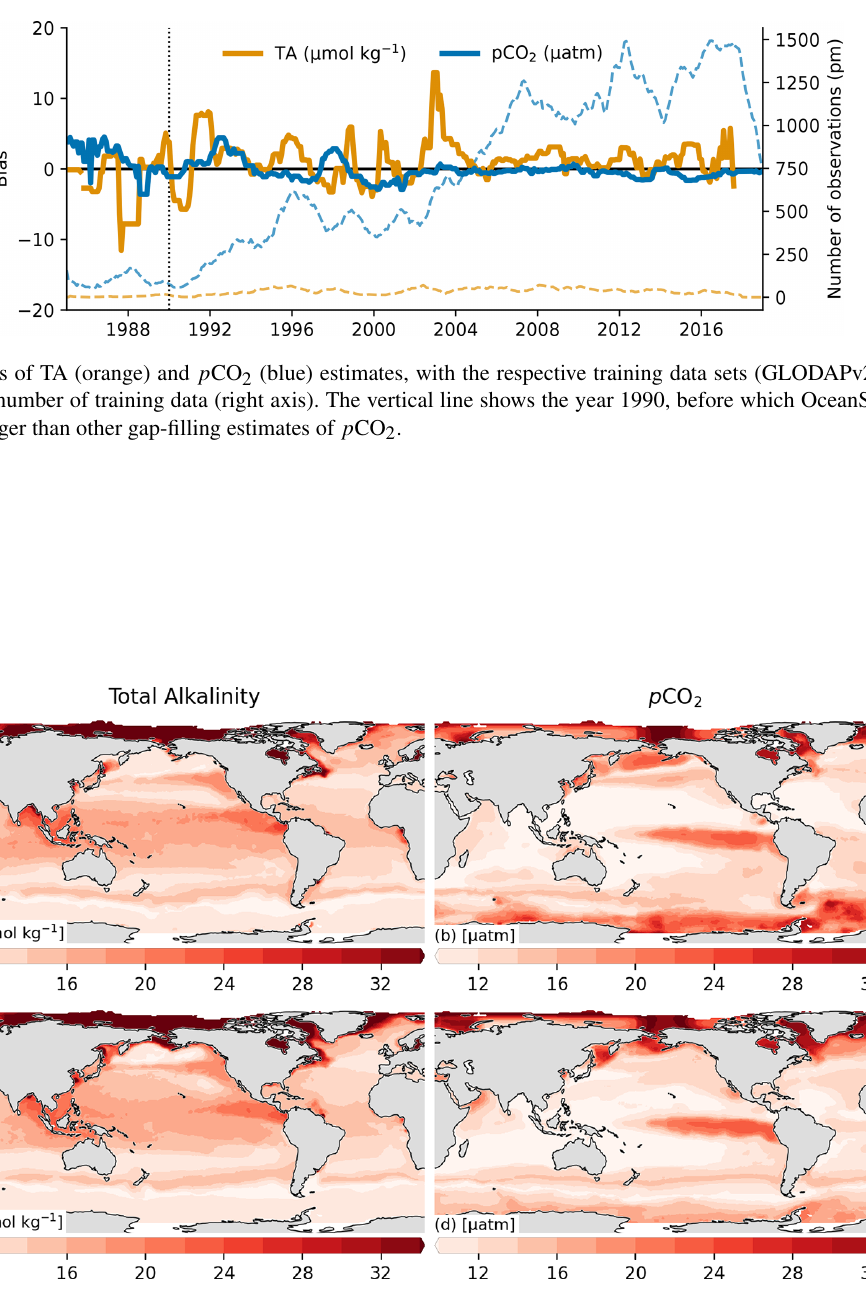
Figure A2. The Huber test scores mapped to the ensemble clusters for total alkalinity (TA) and p CO 2 . The top row shows Huber scores averaged for December, January, and February (DJF) and the bottom row June, July, and August (JJA). The Huber score is a blend between root mean squared error (RMSE) and mean absolute error (MAE), where MAE is applied to values that are considered outliers. Only test data are used to calculate these climatological scores, meaning that the scores are based on GLODAP2 and SOCAT data for TA and p CO 2